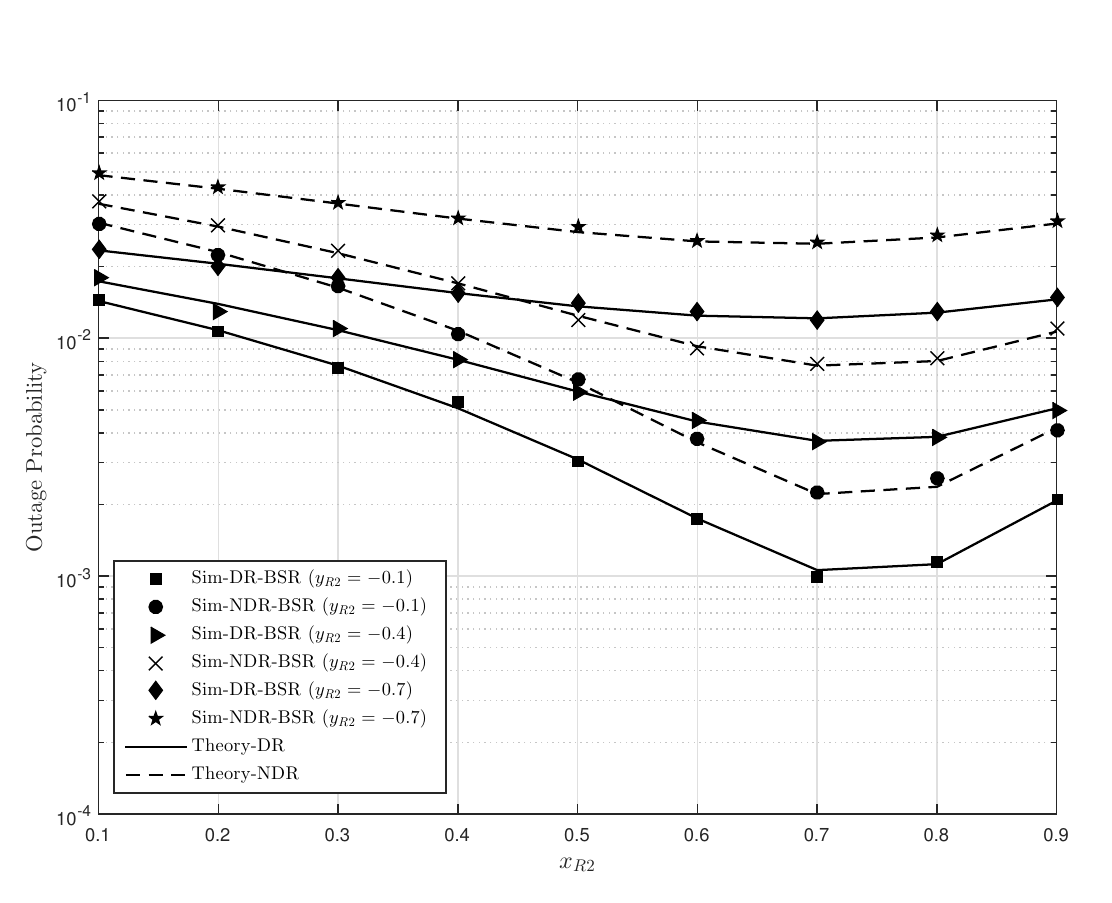
of the DR-BSR and NDR-BSR protocols and for y R 2